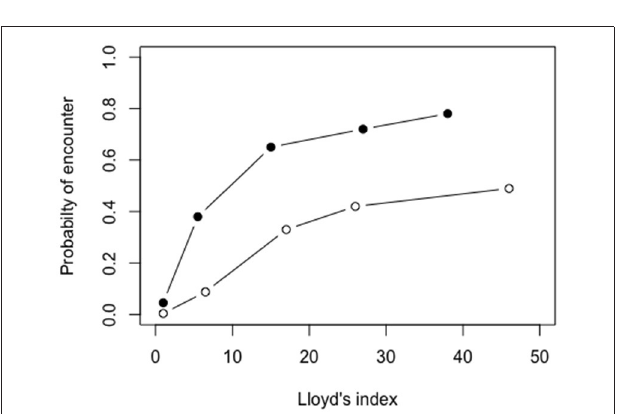
FIGURE 4 | Encounter probabilities of passive larvae as a function of the patchiness of initial larval distribution, implementing high (0.026 ind m − 3 ; full circles) and low (0.0026 ind m − 3 ; empty circles) larval densities. Simulations were carried out in the 3D biophysical model within a sub-sample of 100 × 100 × 100m (length × width × depth) in the Gulf of Aqaba centered around 29 ◦ 29.4 ′ N 34 ◦ 57.4 ′ E during the 15th of March 2004 at 12:00–12:10